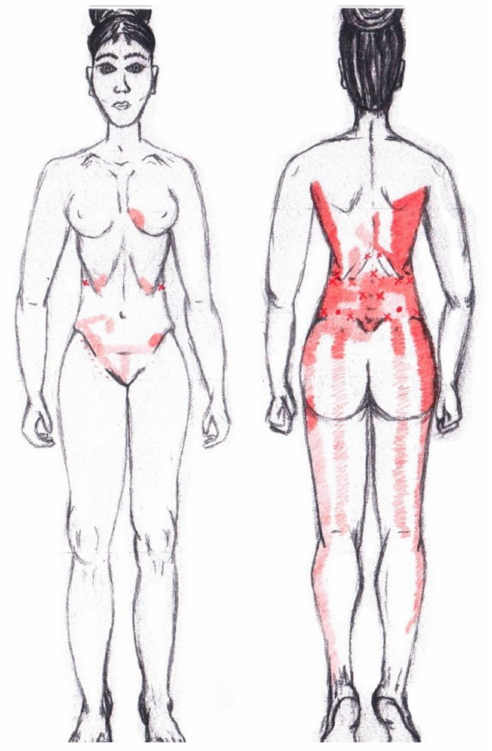
Figure 11. Graphical simulation of referred pain areas of the quadratus lumborum muscle.